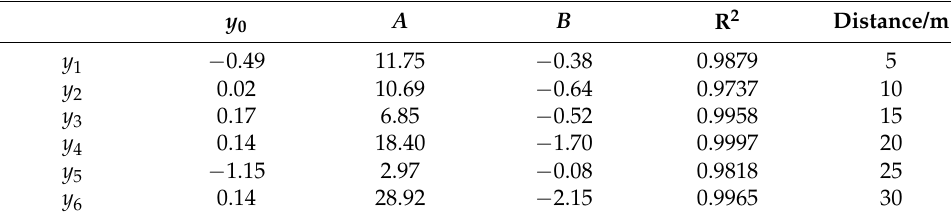
Table 5. The fitting parameters of CO 2 concentration during low-pressure injection.